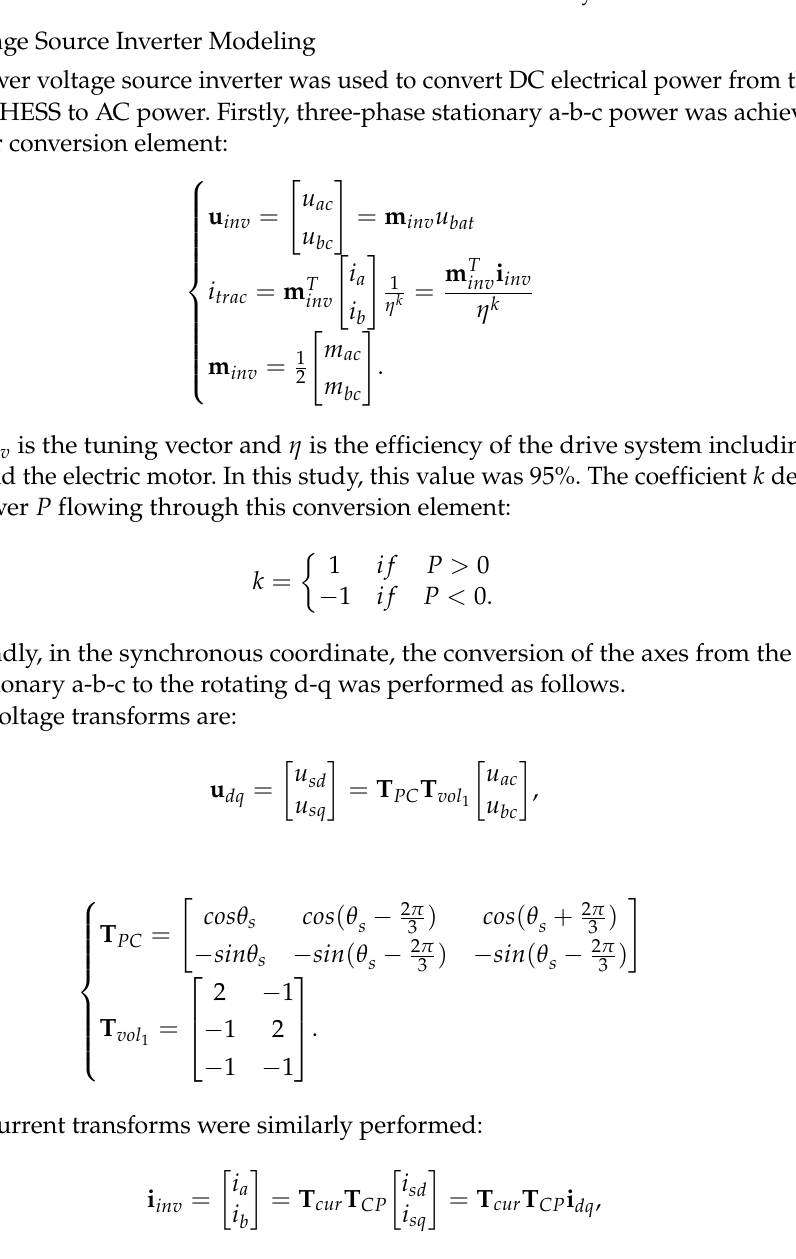
Figure 2. EMR and inversion-based control of the i-MiEV car traction